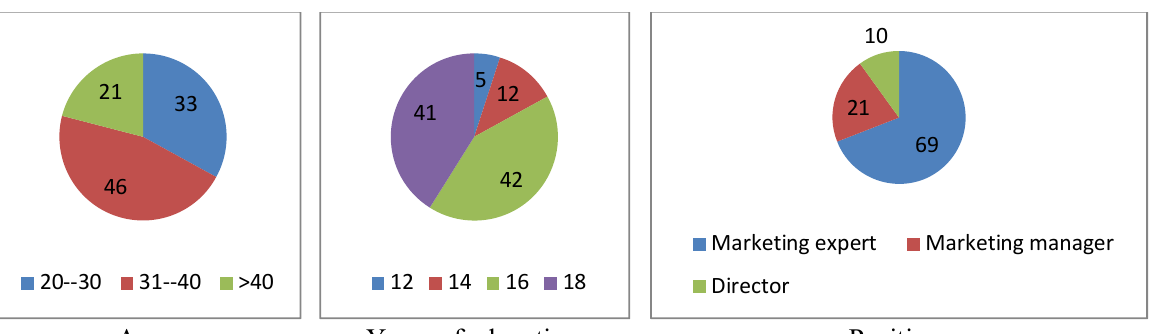
Fig. 1. Personal characteristics of the